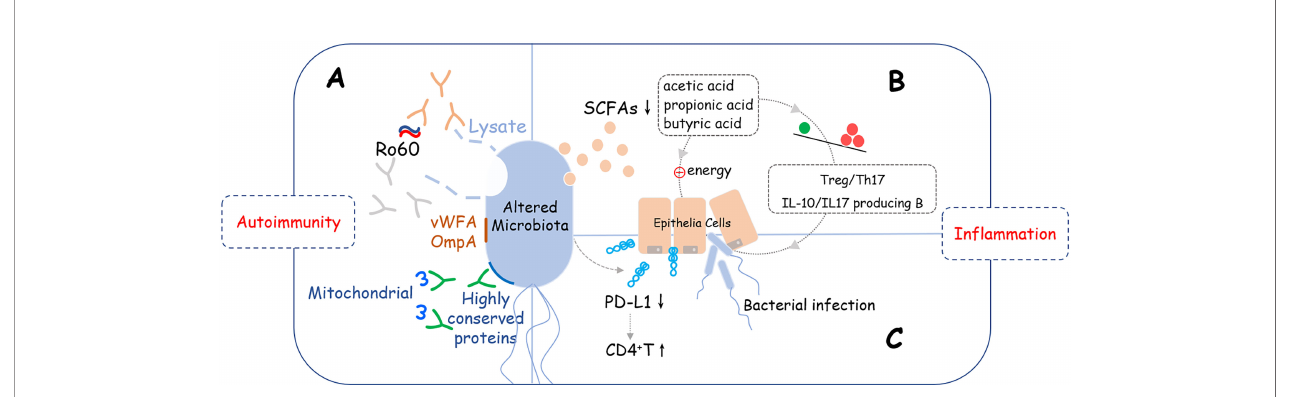
FIGURE 1 | Potential crosslinks between microbiome alteration and pathogenesis of SS. Altered microbiome may induce development of SS via three potential pathways: (A) Molecular mimicry: Lysates, proteins, or peptides that originate from bacteria, including von Willebrand factor type A domain protein (vWFA), OmpA, and some other highly conserved proteins could react with anti-Ro60 antibodies or SSA/Ro60-reactive T cells, which are involved in the activation of excessive autoimmune response; (B) Metabolite changes: Short-chain fatty acids (SCFAs) produced by bacteria were decreased that led to reducing the immune checkpoint molecules and imbalance of T cells (Treg/Th17) and B cells (IL-10/IL-17 producing B cells), which provides a pro-in fl ammation microenvironment is SS. (C) Epithelial tolerance breakdown: Reducing the supply of energy for epithelial cells, disrupting the immunomodulatory function such as down-regulating the expression level of PD-L1 on epithelial cells, and interfering with the mucus barrier are possible mechanisms that epithelial tolerance was broken